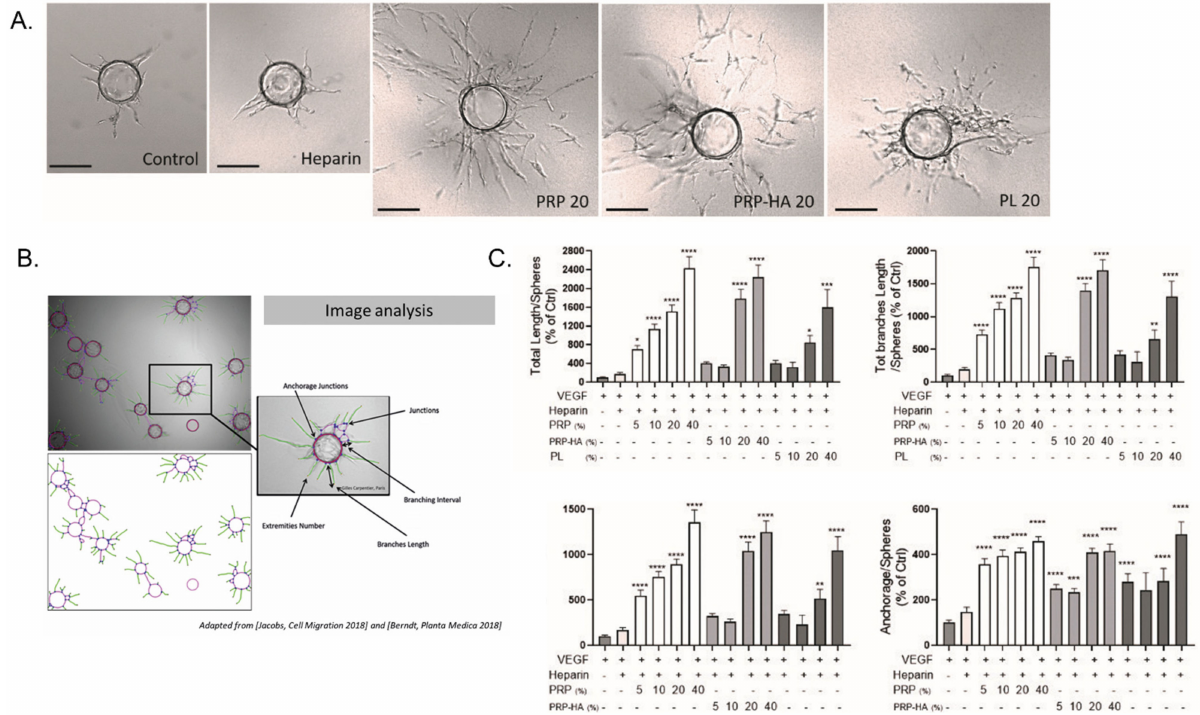
Figure 10. Platelet-derived products differentially modulated angiogenesis in the 3D fibrin bead assay. ( A ) 3D HUVEC cultures were treated with platelet-derived products (PRP, PRP-HA and PL) at different concentrations for 4 days. Representative pictures of massive enhancement of angiogenesis (PRP 20, PRP-HA 20) or slight endothelial proliferation from the EC coated beads (PL20) compared to control conditions (control and heparin) at day 4. Scale bar: 150 µ m. ( B ) Representative images of enhanced angiogenesis. Cytodex microcarrier beads coated with HUVECs exhibiting pseudo-capillary growth after automatic analysis with a specific plugin developed for the Image J software [87]; some of the morphometrical parameters of interest are shown. ( C ) Quantification of morphometrical parameters of the capillary network was performed by a computerized method (thanks to Image J opensource software) on pictures taken on day 4. Representative parameters measured were total length, total length of branches, number of extremities and number of anchorage junctions per sphere. Graphs are representative of three independent experiments. One hundred spheres were quantified for each experimental condition and compared to the heparin-treated cultures. Significant from heparin as measured by the one-way ANOVA followed by Dunett’s multiple comparison test (* p < 0.05, ** p < 0.01, *** p < 0.005, **** p < 0.001). Data from Berndt et al. Biomedicines 2021